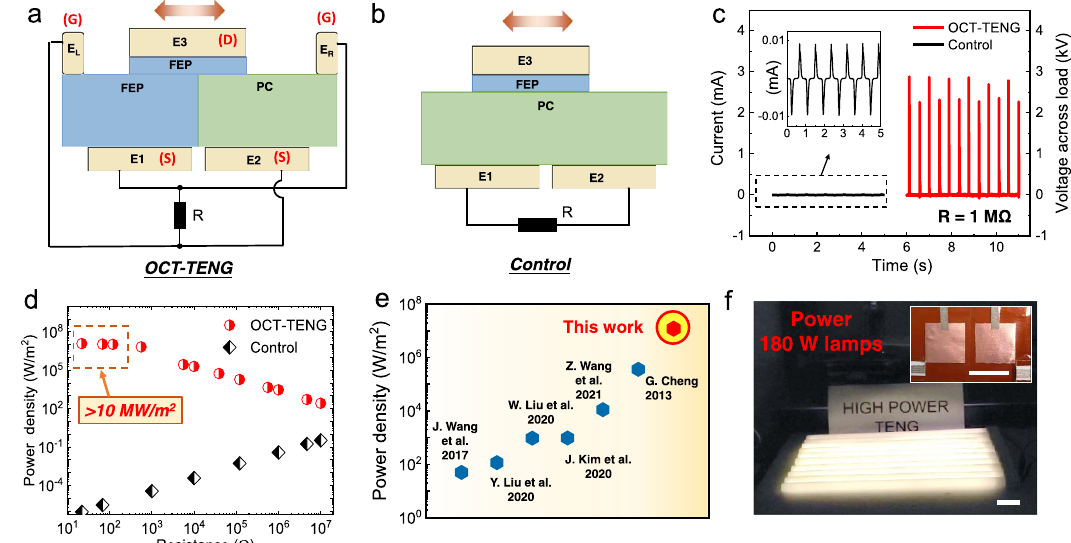
Fig. 1 Design and performance of the OCT-TENG. Schematic of the cross-section of a opposite-charge-enhanced transistor-like triboelectric nanogenerator (OCT-TENG) and b the control device of conventional sliding mode TENG. c Comparison of current output between OCT-TENG and the control device. (load resistance R of 1 M Ω ) d Comparison of pulsed power depending on load resistance between OCT-TENG and the control device. e Comparison of the instantaneous power density obtained in this work with other reports 13,19,28,29,32,33 . f , the photograph of 180 W lamps being powered by an OCT-TENG. Insert shows the photograph of the OCT-TENG. Scale bars in f and insert are 5 cm.